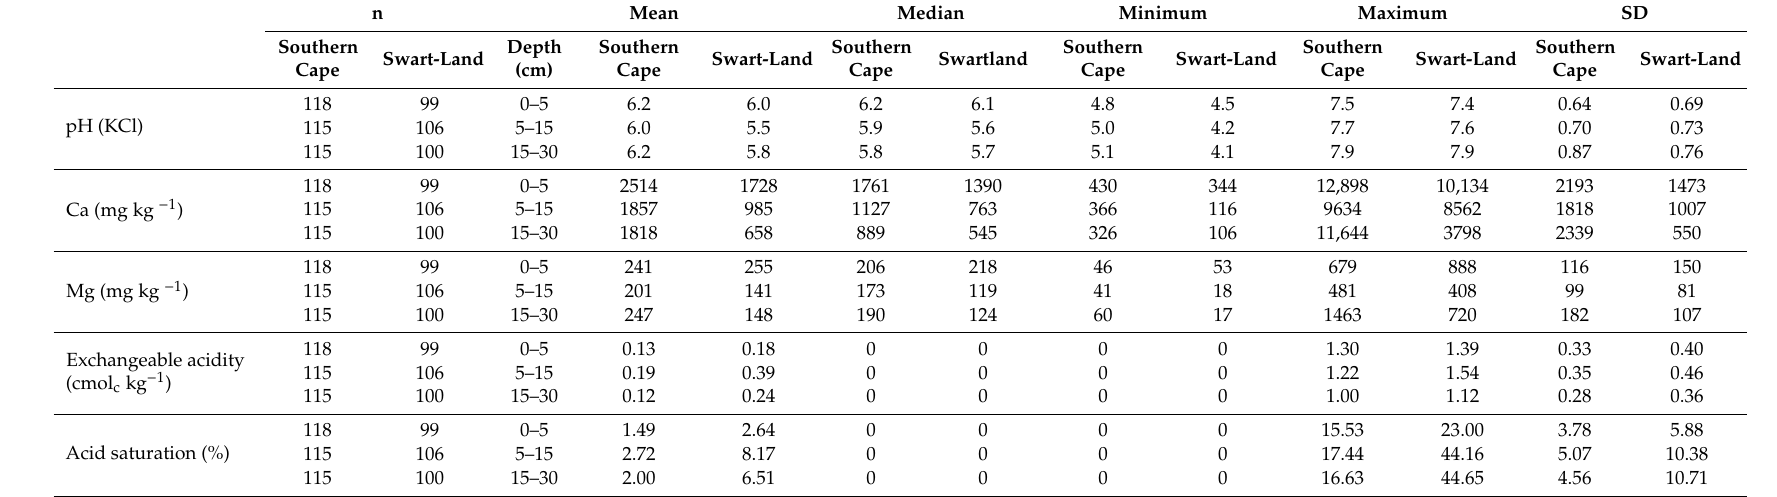
Table 1. Descriptive statistics of soil chemical attributes between three depths (0–5, 5–15 and 15–30 cm) for soils sampled in the southern Cape and Swartland regions. SD = standard